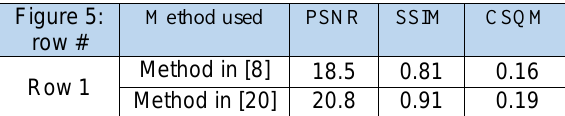
Table 4 below summarises the calculated measures: PSNR, SSIM, and CSQM to compare our technique with the methods in [8] and [20]. Table 4. Inpainted image quality assessment comparison using PSNR, SSIM, and CSQM. Figure